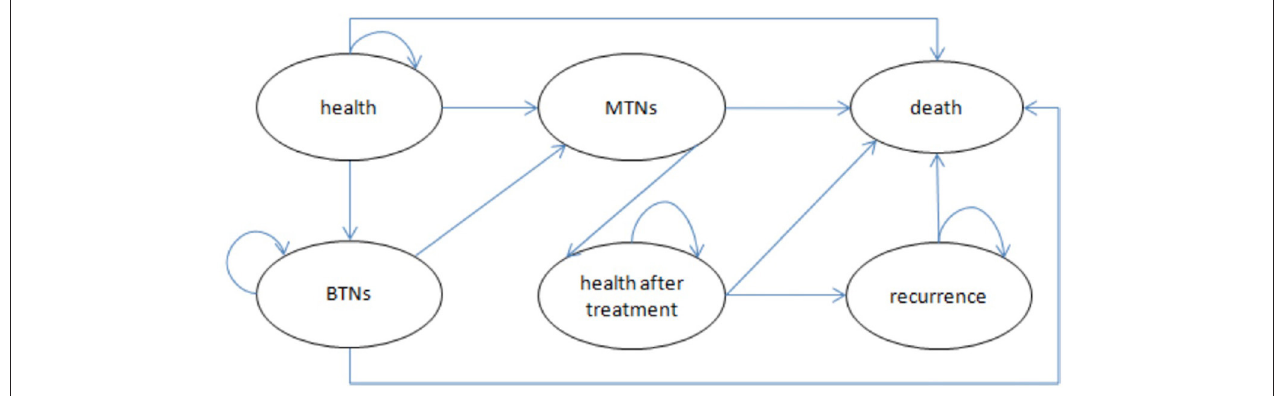
FIGURE 1 | Bubble chart of Markov model. BTNs, benign thyroid nodules (state); MTNs, malignant thyroid nodules (state).